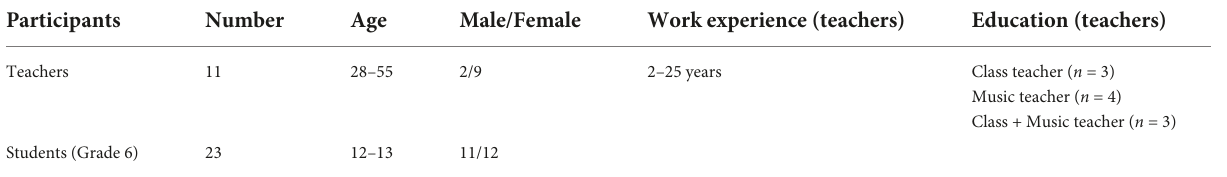
TABLE 1 Backgrounds of the participants in the